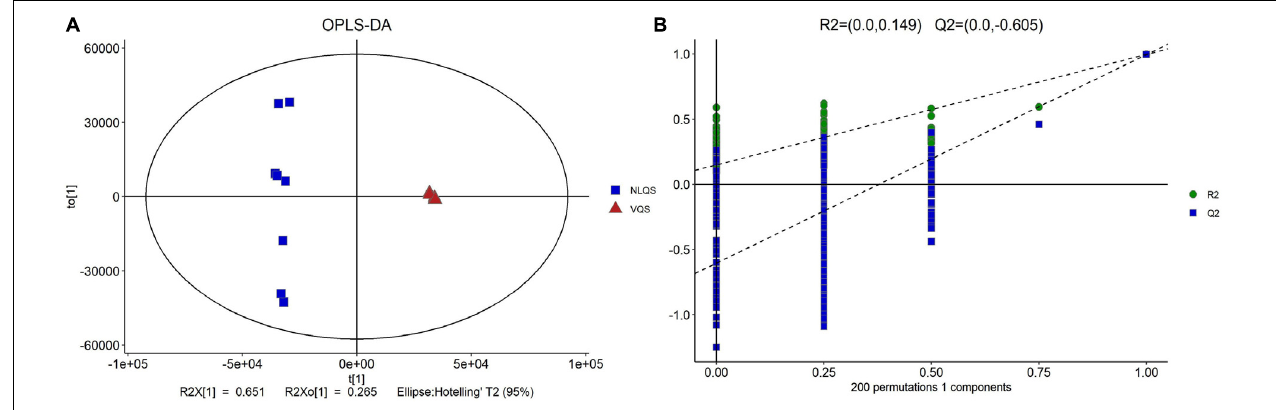
FIGURE 1 | Multivariate statistical analyses of the differences in metabolites between NLQS and VQS in the honeybee Apis mellifera . (A) Orthogonal partial least-squares-discriminant analysis (OPLS-DA) was conducted using the OmicShare cloud platform powered by Gene Denovo Biotechnology Co., Ltd https://www.omicshare.com/tools/. R 2 X = 0.651; R 2 Xo = 0.265; Ellipse: Hotelling’ T2 (95%). (B) Permutation test plot. R 2 = (0.0, 0.149); Q 2 = (0.0, -0.605).